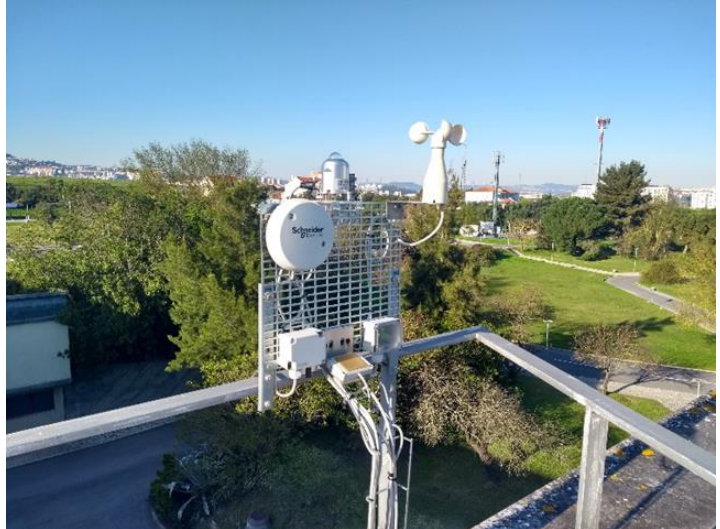
Figure 4. Weather station on the roof of Solar XXI. Table 2. Applied sensors.